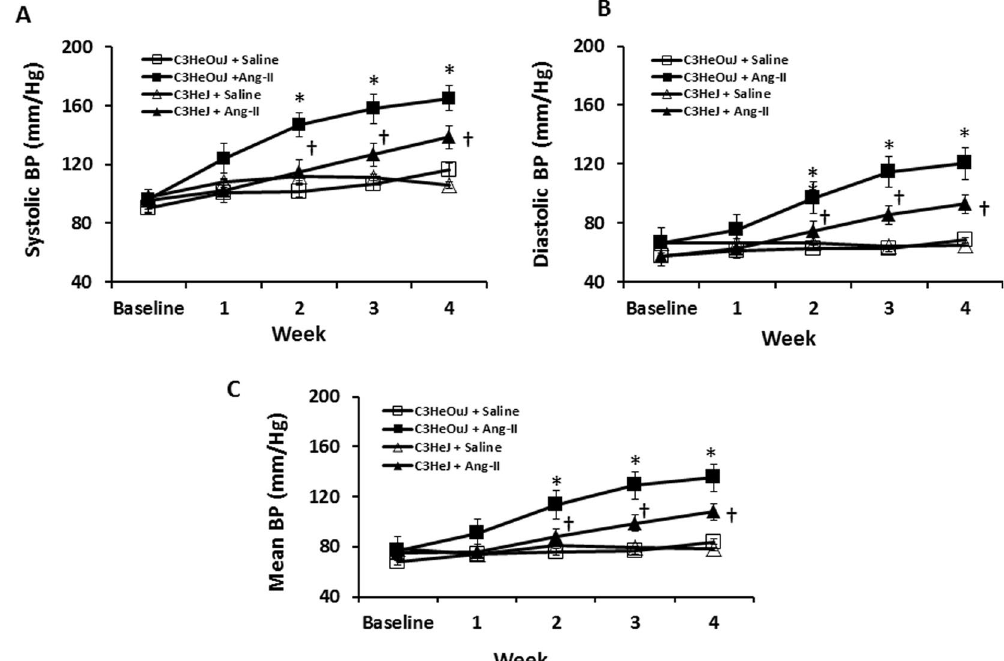
Figure 1. TLR4 deficiency mice exhibit blunted response to Ang-II induced hypertension. Time course of systolic, diastolic and mean blood pressure changes following Ang-II treatment in C3H/HeOuJ (C3HeOuJ, normal TLR4) and C3H/HeJ (C3HeJ, TLR4 deficiency) mice. n = 7/group tested by ANOVA followed by Student’s t-test. * p < 0.05 vs. Saline groups; † p < 0.05 vs. C3HeOuJ +